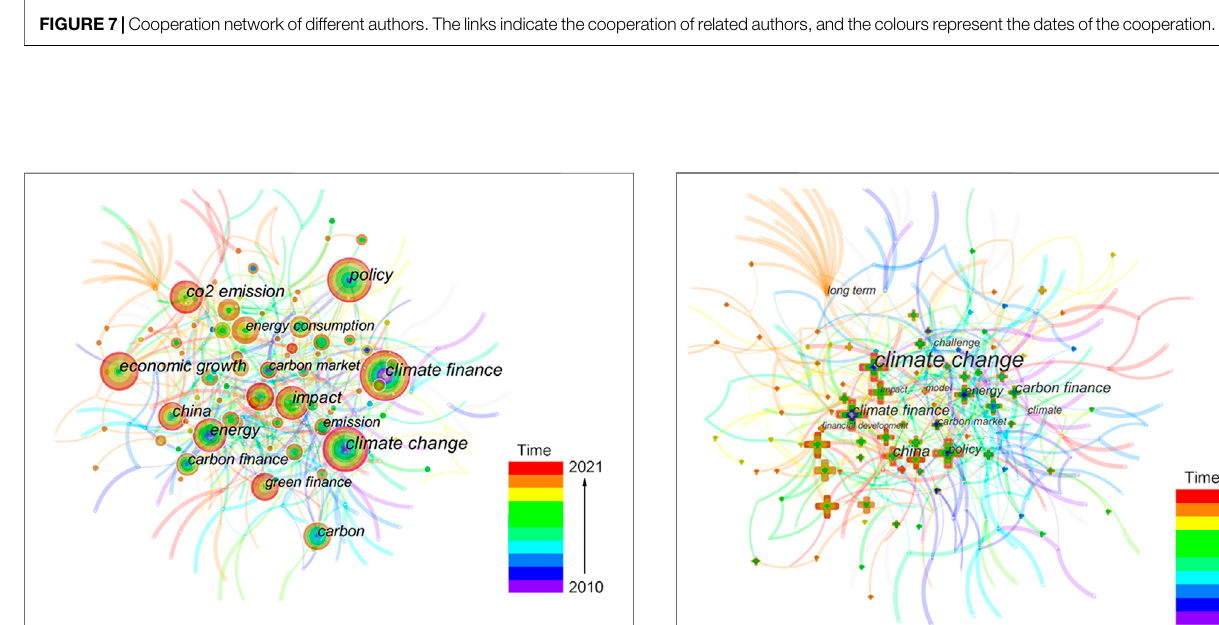
FIGURE 8 | Network of keywords by frequency. The links indicate the connections of related keywords, and the colours represent the dates of the connections. The size of a circle is proportional to the frequency of the keywords.